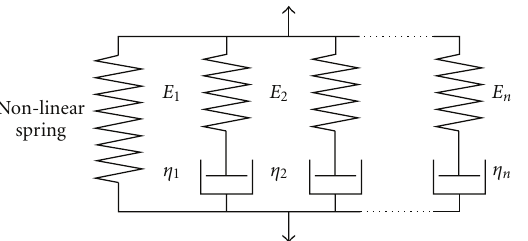
Figure 4: The n -term generalized Maxwell-model ( E i : elastic modulus of the i th spring, η i : viscosity of the i th dashpot).